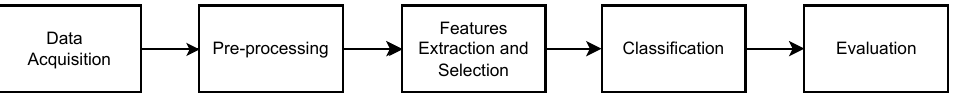
Figure 1. Standard approach to developing machine learning and pattern recognition systems. Each step should be optimized in parallel to achieve the best